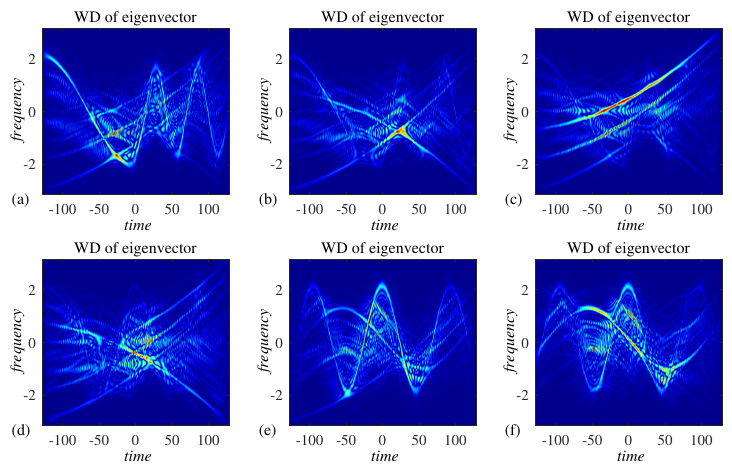
Figure 12. ( a – f ) Time-frequency representations of eigenvectors corresponding to the largest six eigenvalues of autocorrelation matrix R of signal from Example 3. Each eigenvector represents a linear combination of non-stationary components with polynomial frequency modulation.